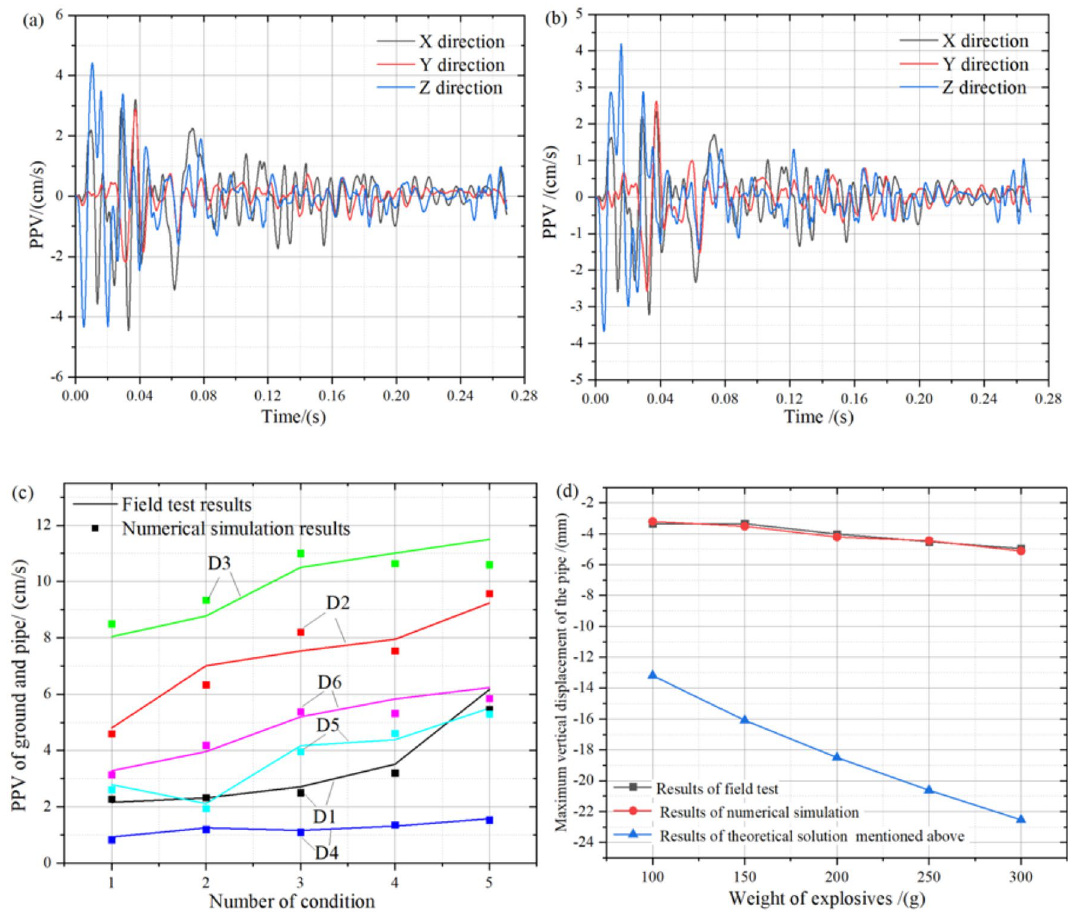
Figure 7. Comparison of field measured data and numerical simulation: ( a ) field test results of D1 , ( b ) numerical simulation results of D1 , ( c ) PPV of ground and pipe, ( d ) comparison of results of the field test and numerical simulation with a theoretical